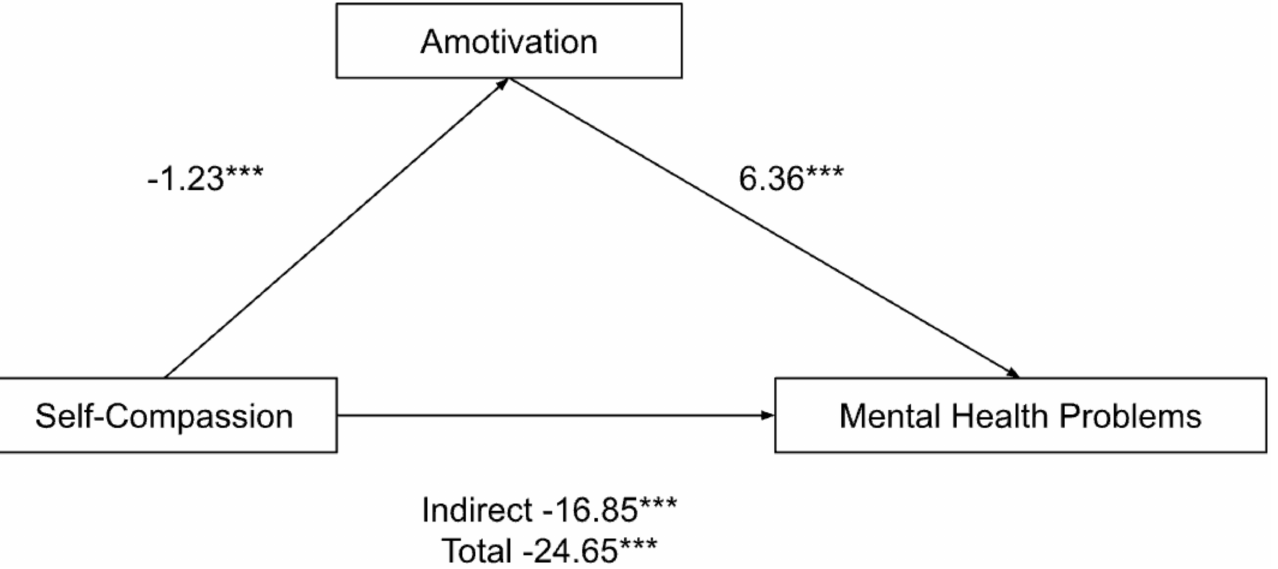
Figure 3. Parallel mediation model: self-compassion as a predictor of mental health problems (depression, anxiety and stress), mediated by amotivation. *** p <